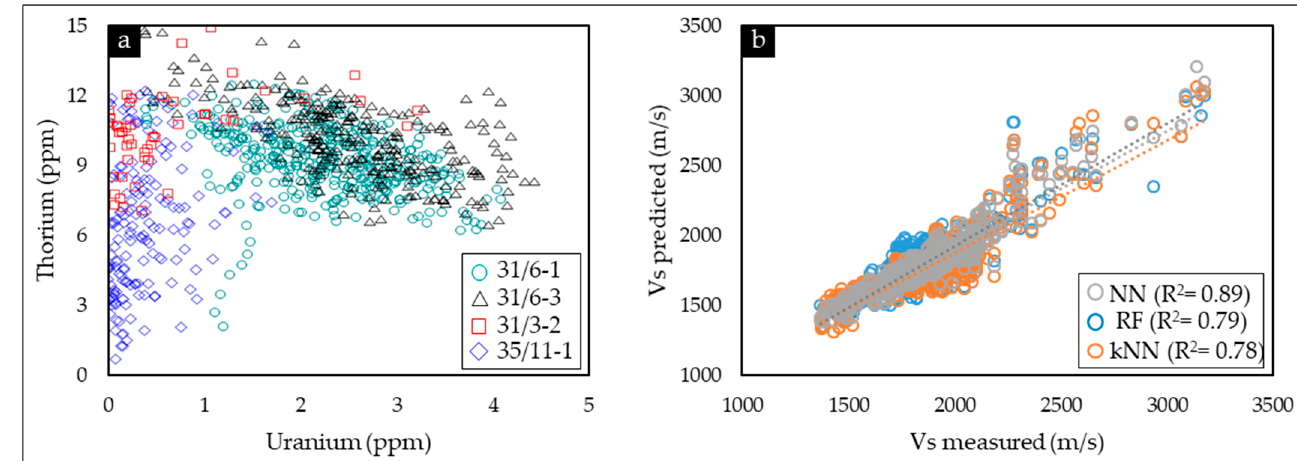
Figure 6. ( a ) Uranium versus thorium cross-plots of the lower Drake unit clearly show the variation of spectral gamma-ray values within the four studied wells. ( b ) A comparison between machine learning algorithms estimated vs. with the measured Vs. The Drake Formation data points from well 31/1-1 were used to construct the crossplot.